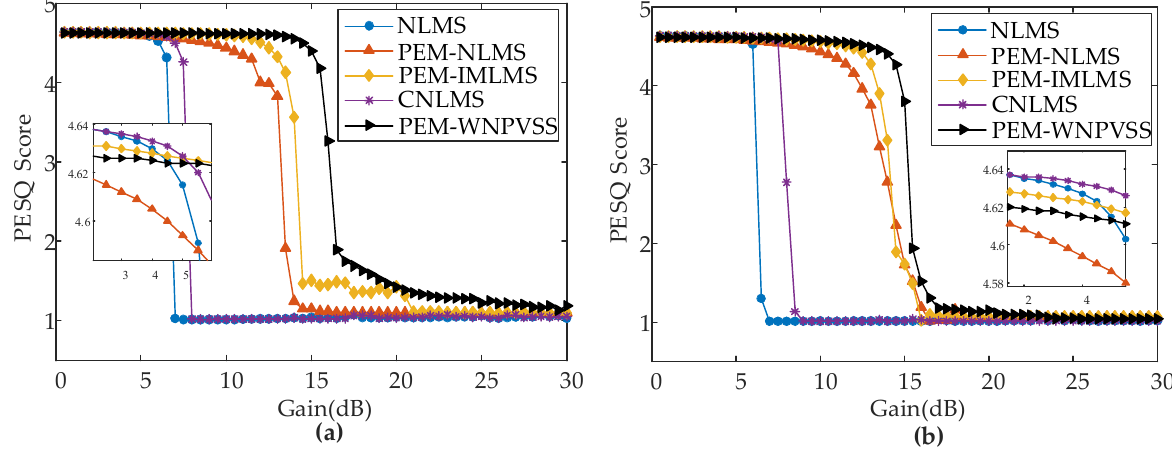
Figure 7. Performance of five algorithms with an impulse noise input: ( a ) MIS; ( b ) ASG. In particular, although the proposed algorithm in this paper is also affected by impulse noise, it is able to adjust to steady-state in a timely manner. Additionally, due to the presence of a weighting mechanism, e w ( n ) is reduced when the value of MIS is low, resulting in a relatively smooth overall trend for both the ASG and MIS of this algorithm, demonstrating strong resistance to interference. Sound quality: As shown in Figure 8, at lower gain levels before reaching the MSG, the two algorithms without using PEM exhibit slightly better PESQ than the other three algorithms. However, as the gain increases, the two algorithms become unstable first, resulting in a sharp decrease in their PESQ to around 1. Because the proposed algorithm in this paper has the highest ASG among these five algorithms, the PESQ of this algorithm is the last to be reduced.